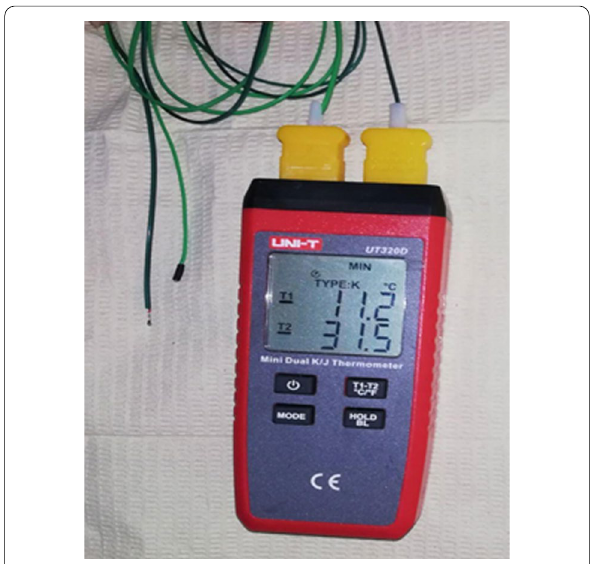
Fig. 1 K-type temperature probe and thermometer device